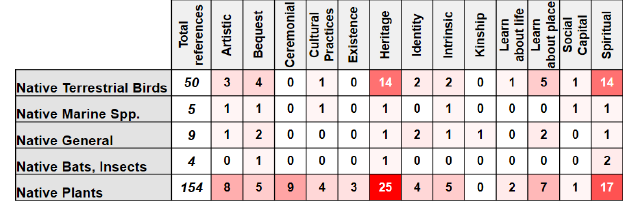
Fig. 7 . References to native species and intangible values. Fig. 8 . Average number of times native species mentioned per interviewee, by interviewee